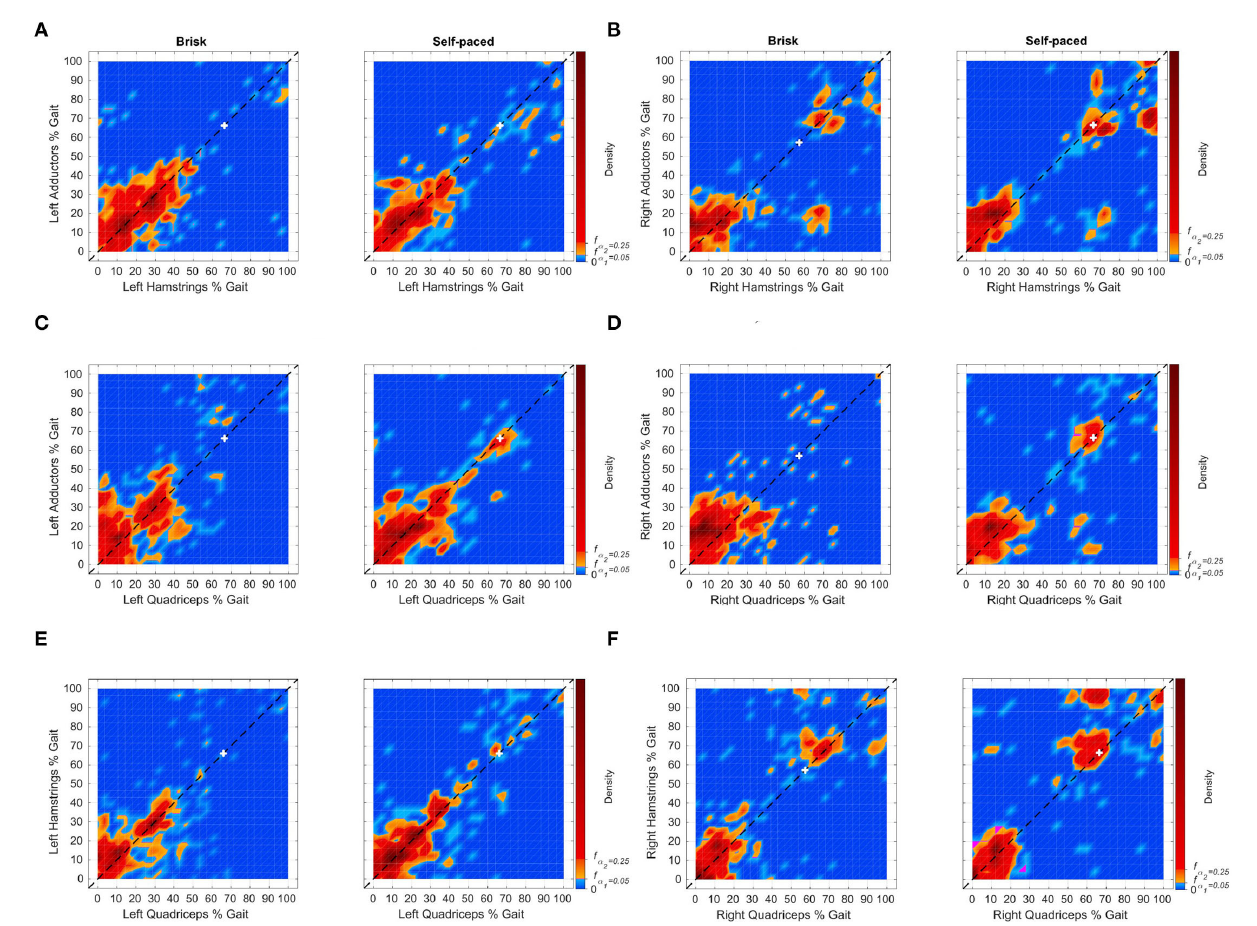
FIGURE 3 | Distributions of muscle peak pairing times between adductors, hamstrings, and quadriceps muscle groups from 6 matched controls for the left (A,C,E) and right (B,D,F) limbs. Individual points can be found in Supplementary Figure S7 . Time zero corresponds to the heel-strike of the corresponding limb. Pairings that occur near or along the diagonal indicates co-contraction between muscle groups. The white cross indicates the mode of the distribution of the stance duration. Distributions of the stance duration are shown in Supplementary Figure S3 . The subfigures depict the densities of peak pairings during the gait cycle. Orange and red indicate periods within the 95% HDR. Red indicates points within the 75% HDR. Magenta refers to time points with density equal to the 95% HDR threshold, f α 1 . For the left limb, large HDRs for co-contraction are prior to 60%, for all muscle pairs. Small HDRs also occur during the swing for selfpaced walking between